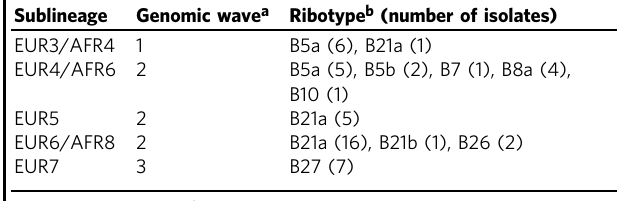
Table 5 Correlation between genomic data and